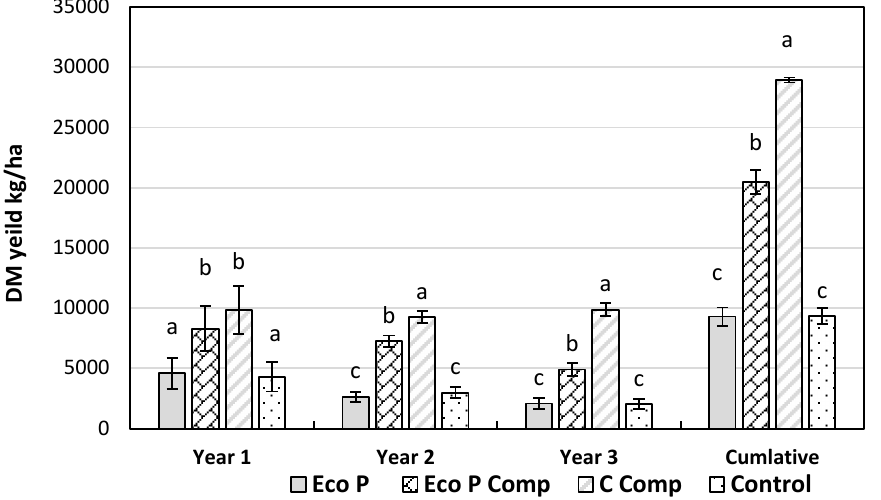
Figure 7. The yearly cumulative effect of fertiliser treatment on grass DM yield and cumulative yield comparison over the full trial; within each harvest shared letters denote that no statistically significant difference occurred ( p > 0.05); error bars indicate standard error.